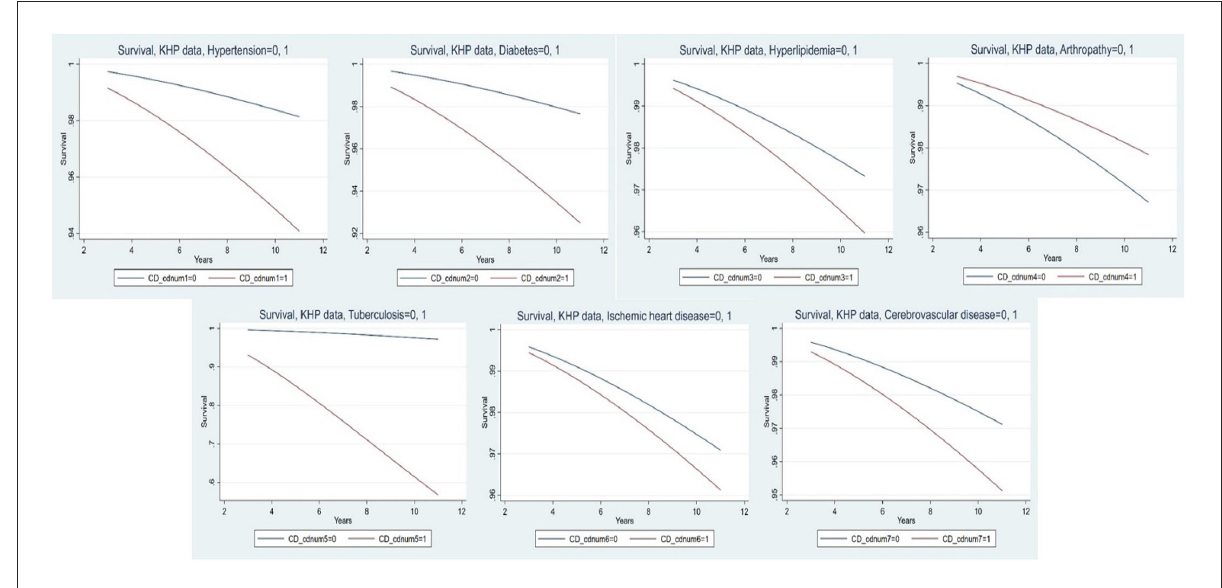
FIGURE2 Major chronic diseases of newly developed